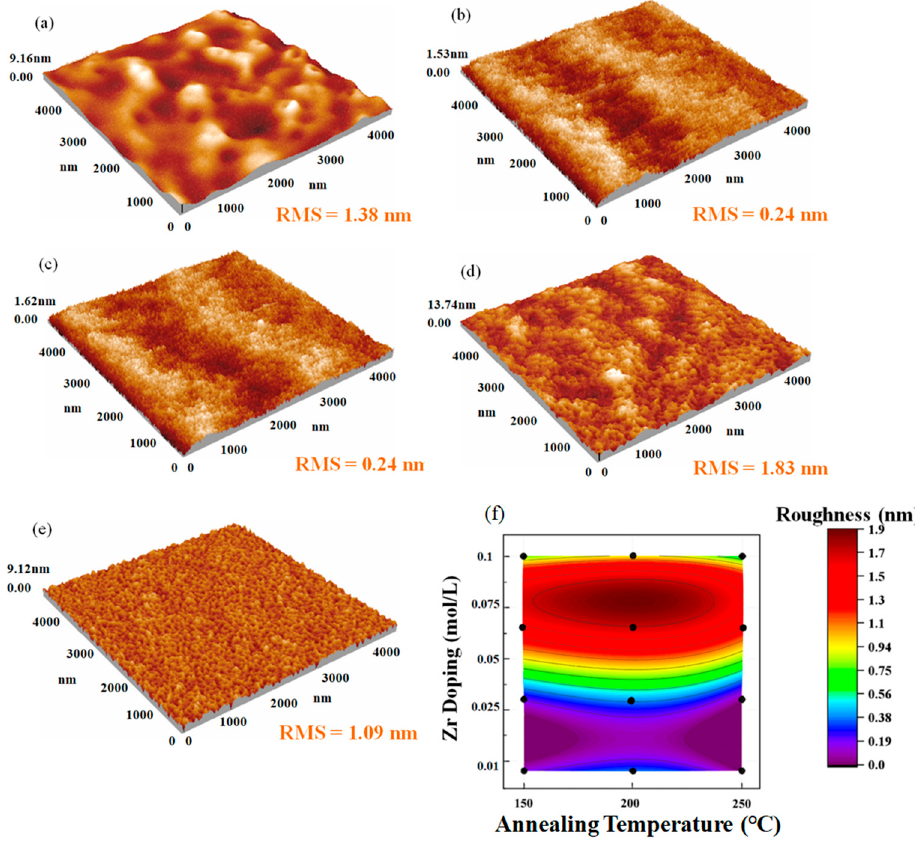
Figure 5. Atomic force microscope (AFM) images of different Zr–AlO x films at 200 °C annealing temperature. ( a ) Pure aluminum solution with plasma treatment; ( b ) 0.01-mol/L Zr-doping solution; ( c ) 0.025-mol/L Zr-doping solution; ( d ) 0.05-mol/L Zr-doping solution; ( e ) 0.1-mol/L Zr-doping solution; ( f ) Contour map of the relationship between annealing temperature and Zr-doping concentration of Zr–AlO x films surface roughness.